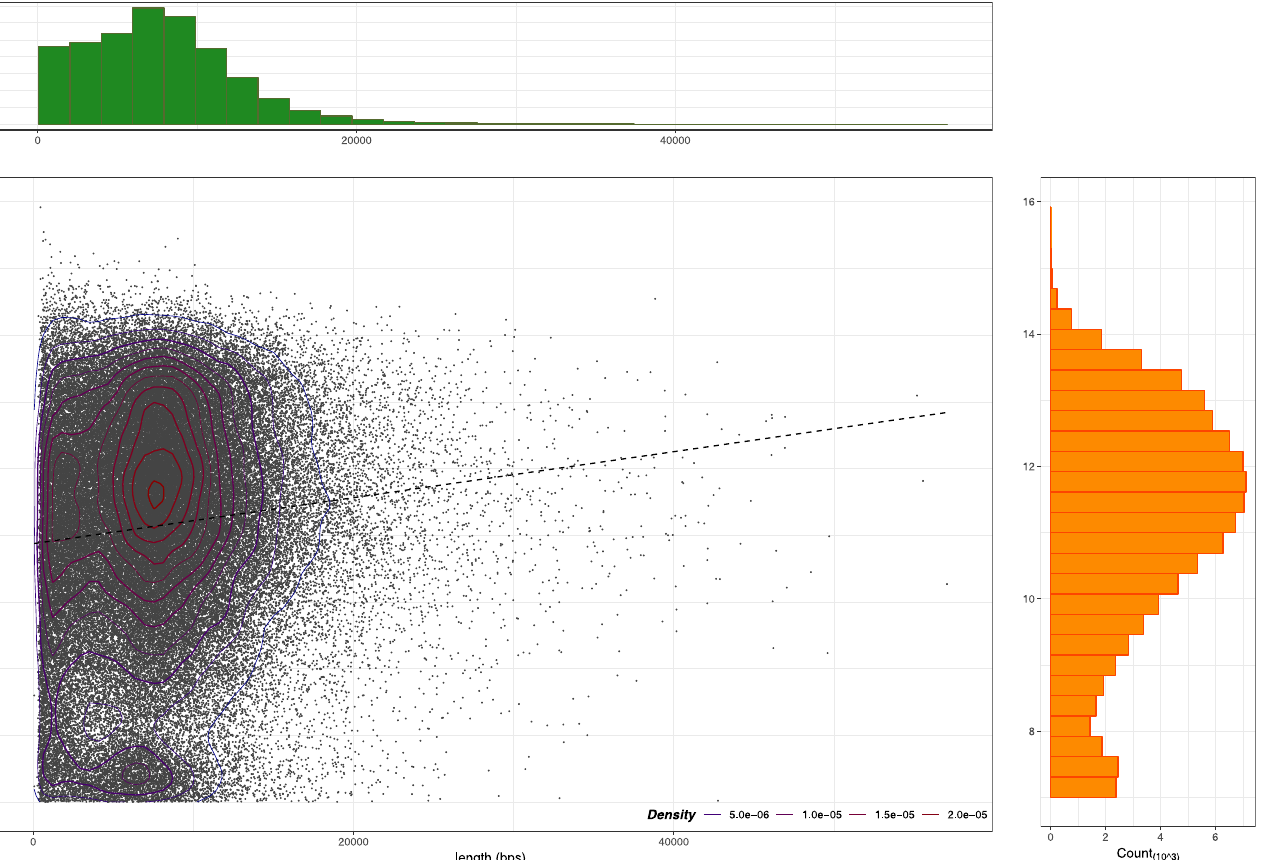
PLOS ONE | https://doi.org/10.1371/journal.pone.0216471 May 9,